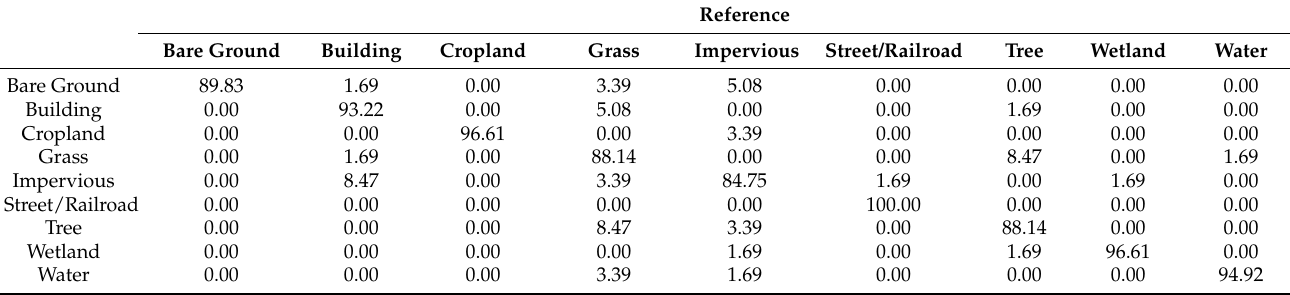
Table A2. Confusion matrix (2014). Values are percent (%) of samples classified (rows) and refer- enced